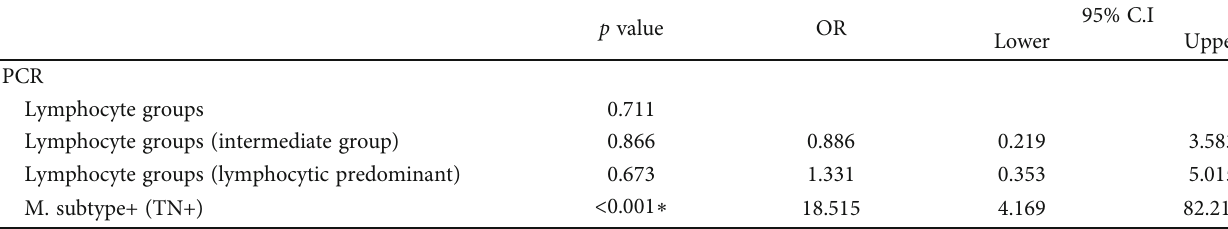
Table 4: Logistic regression to analyze role of molecular subtype.